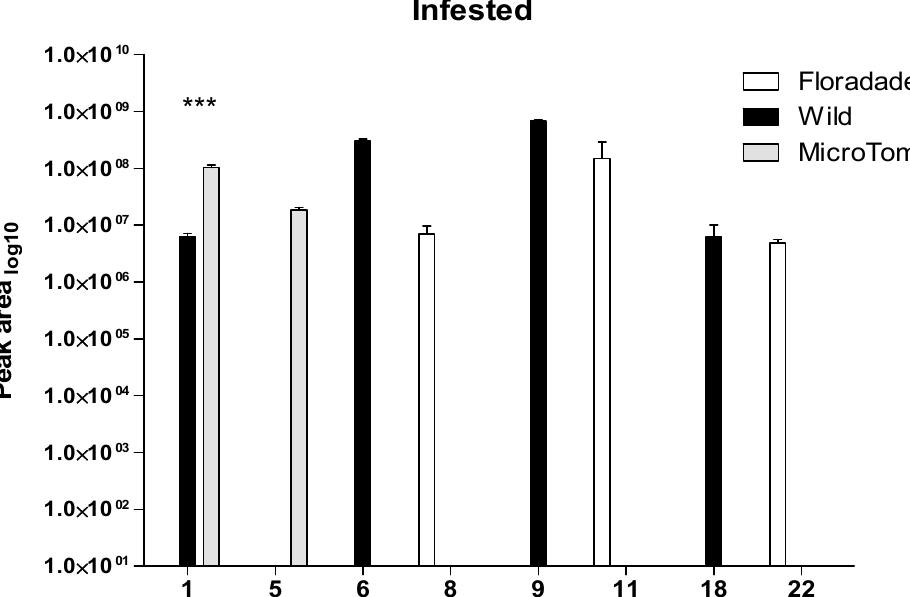
Figure 3. Plant volatiles from infested plants of three varieties of tomato. Compounds were presented in profile and were obtained from the three varieties for two bioassays in infested tomato plants: Floradade (white bars), wild (black bars), and Micro-Tom (gray bars). Compounds: α -pinene ( 1 ), β -pinene ( 5 ), (+)-4-carene ( 6 ), (+)-2-carene ( 8 ), β -phellandrene ( 9 ), (+)-sabinene ( 11 ), caryophyllene ( 18 ), and phenol, 2,6-bis(1,1-dimethylethyl)-4-(1-ethylpropyl)- ( 22 ). Values are means ± SE, n = 6. Level of significance: ***, P < 0.001. (Univariate ANOVA, non-parametric Kruskal-Wallis test at P = < 0.05).